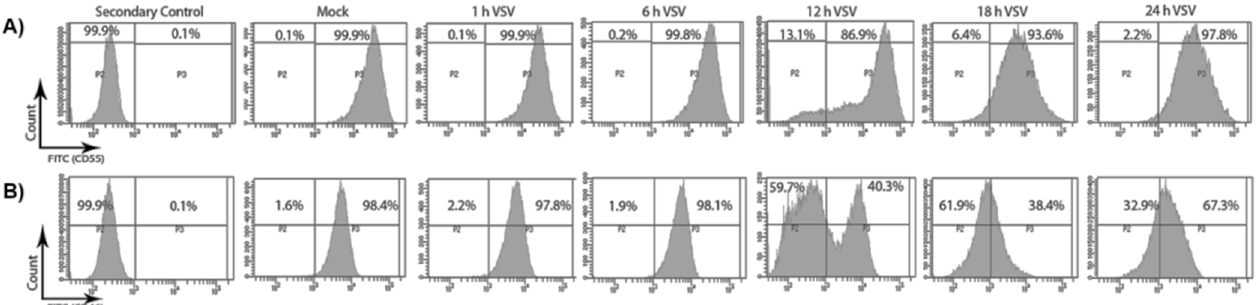
Figure 2. VSV infection causes a decline in the surface expression of CD46 and not CD55. HeLa cells were infected with VSV (10 MOI) for the specified time points. The surface distribution of CD55 and CD46 was determined by staining the mock- and VSV-infected cells with anti-CD55 and CD46 primary antibodies, and by counter staining with AF488-labelled secondary antibody. The two panels, A and B , denote the histogram representing the fluorescence intensity on the x -axis and the cell count on the y -axis. The infection of the HeLa cells with VSV did not alter the surface level expression of CD55 ( A ) even until 24 h; however, a drastic reduction in the surface expression of CD46 ( B ) could be evidenced 6 h post infection.